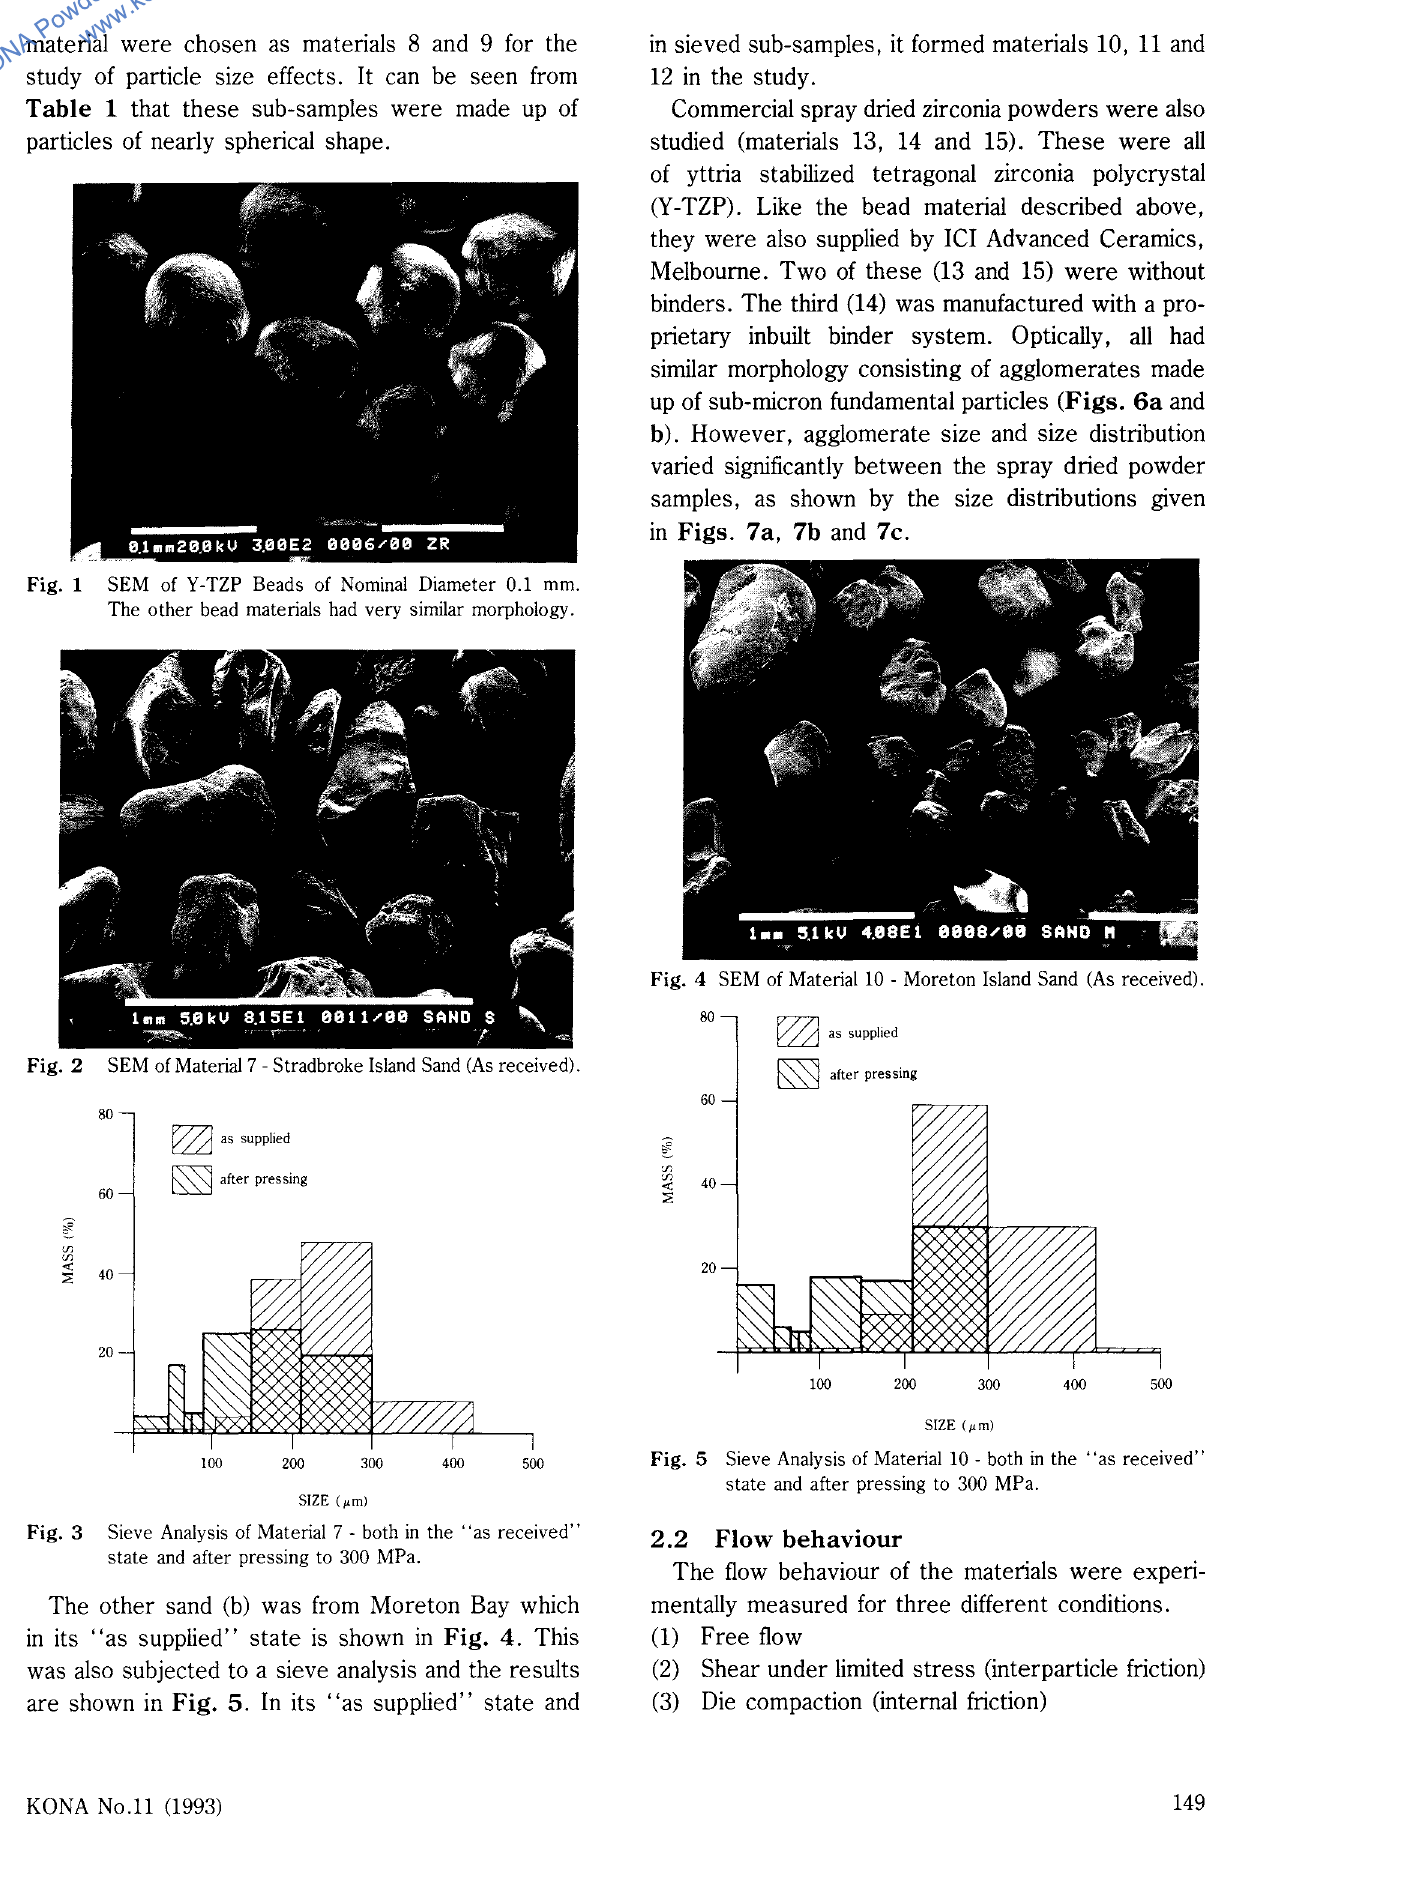
SEM of Material 7 - Stradbroke Island Sand (As received).